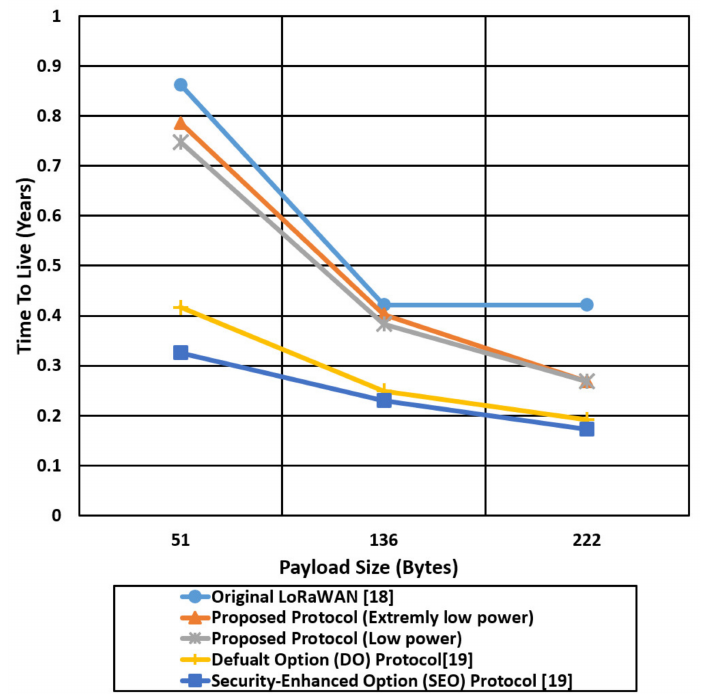
Figure 19. Comparison of the battery lifetime in terms of years for the proposed protocol cases and the other mentioned protocols using the worst-case environment parameters (SF 12).